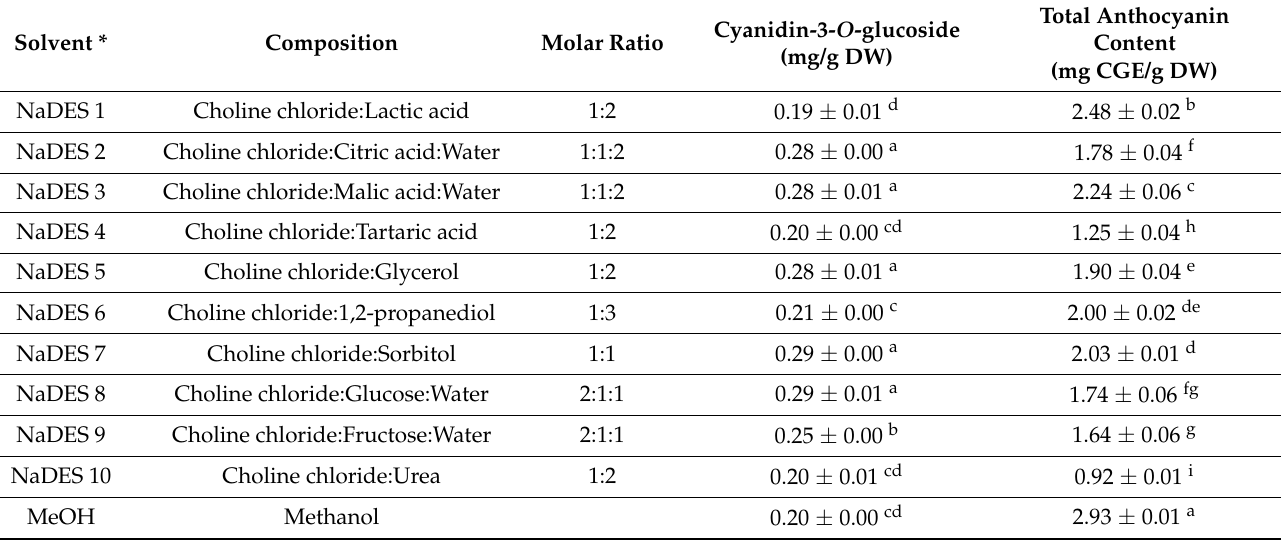
Table 1. List of natural deep eutectic solvents estimated in initial screening analysis for the extraction of total anthocyanins and cyanidin-3- O -glucoside from bilberry fruits.